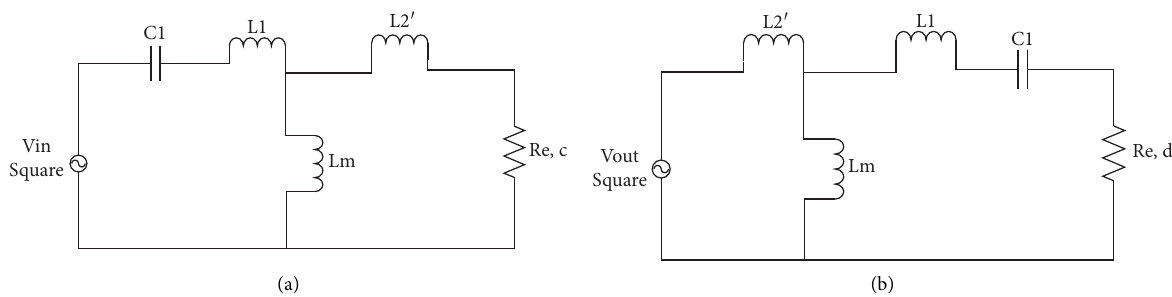
Figure 3: Schematic of the proposed converter’s equivalent circuit model in (a) forward power fow mode and (b) reverse power fow